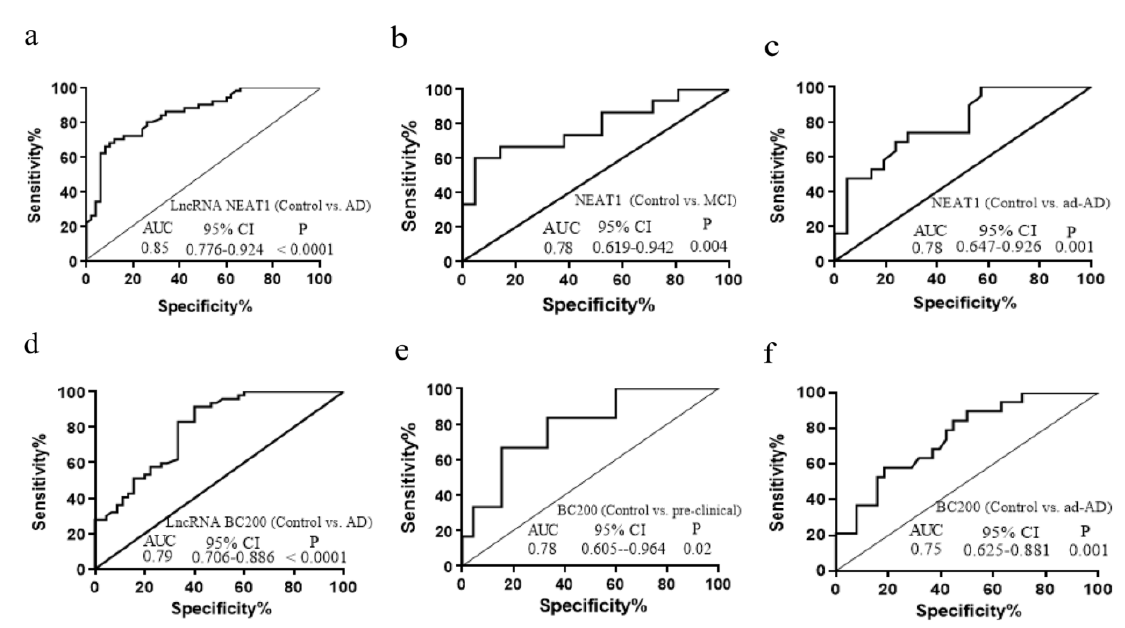
Figure 5: The ROC curve analysis for discriminative power of the plasma levels of lncRNAs. a ) the NEAT1 level for AD versus control, b ) MCI versus control and c ) ad-AD versus control. ROC curve analysis on the BC200 level for d ) AD versus control, e ) pre-clinical versus control and f ) ad-AD versus control. AUC = area under the ROC curve, ROC = receiver operating characteristic